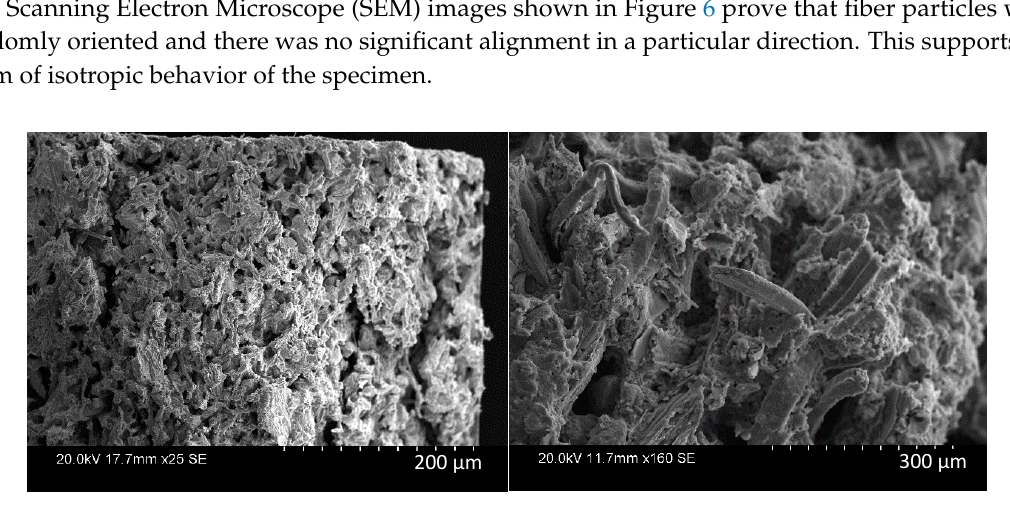
Figure 7. Isometric view of sample in simulation showing tensile stress in tension test.